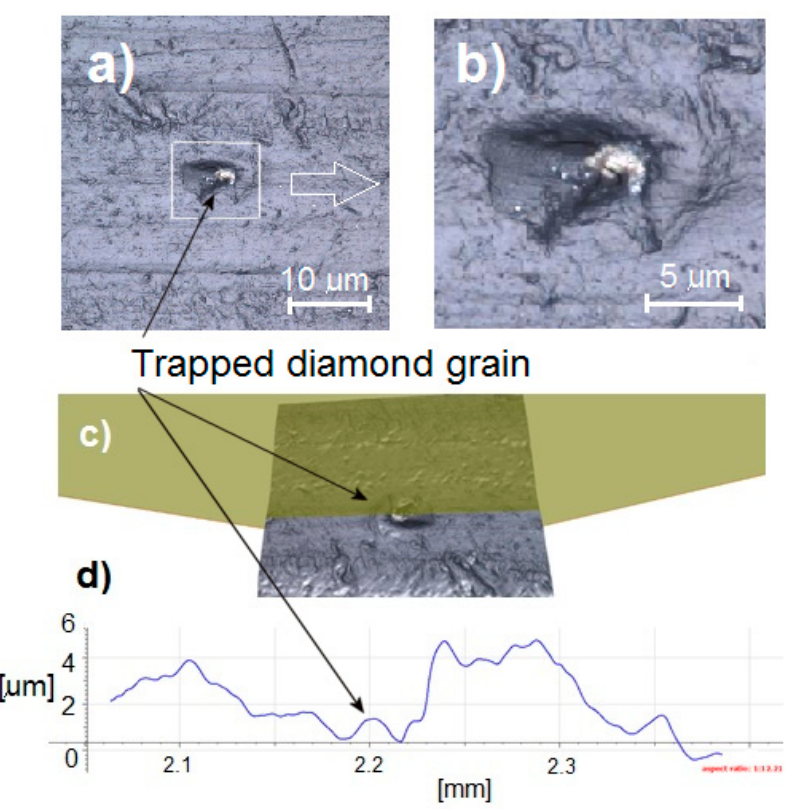
Figure 21. A trapped diamond grain in the UHMWPE. ( a , b )—a detail of the damaged surface, ( c ) a cross section of the place, ( d ) a profilogram of the inclusion according to the cut at location ( c ). The last way to smooth the machined surface was thermal ironing of the irregularities, because the temperature for UHMWPE softening is very low—around 135 ◦ C (see Table 1). A polished steel ball of 30 mm in diameter (Figure 22), a steel bearing of 50 mm in diameter (preheated in an oven), a commercial flat iron (with inner electrical heating), and a special apparatus was used for this experiment. In actuality, the hand polishing operation worked very well, with a reduction of all amplitude characteristics of about 50%—Figure 23, Table 2. The results cannot be overestimated, because there is no information about chemical bonds in the UHMWPE surface and their